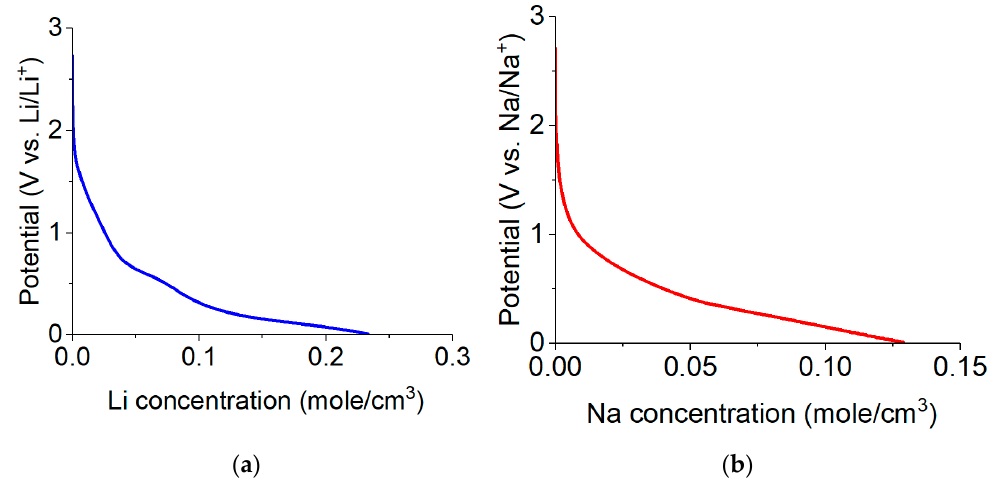
Figure 7. Concentration dependence of potential for lithium ( a ) and sodium ( b ) insertion into CoGe 2 P 0.1 .